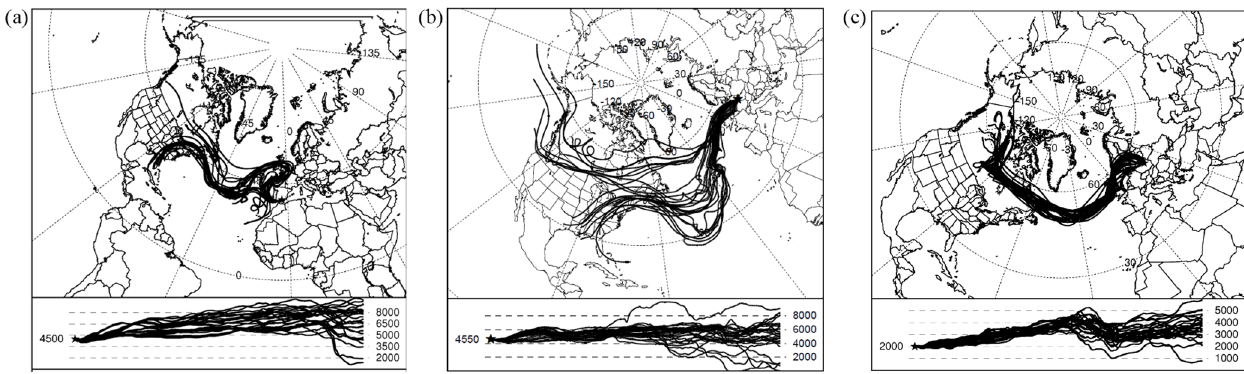
Figure 4. Coordinates and altitude in meters above ground level (black lines) of the ensembles of probable air masses’ trajectories ending at the investigated layer on 14 July 2013 above Granada (a) , on 17 July 2013 above Leipzig (b) and on 9 July 2013 above Warsaw (c) .